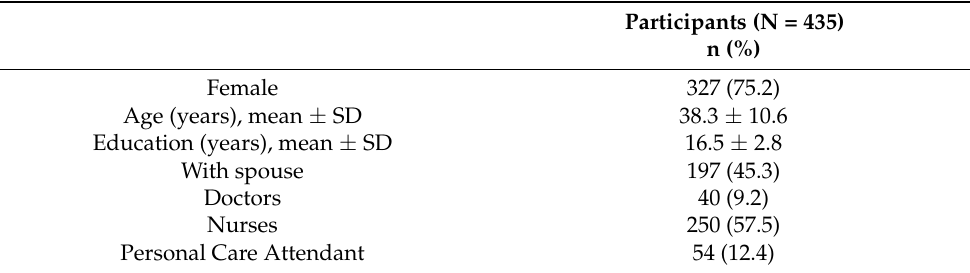
Table 1. The demographic data and questionnaire ′ s among participant (N = 435).